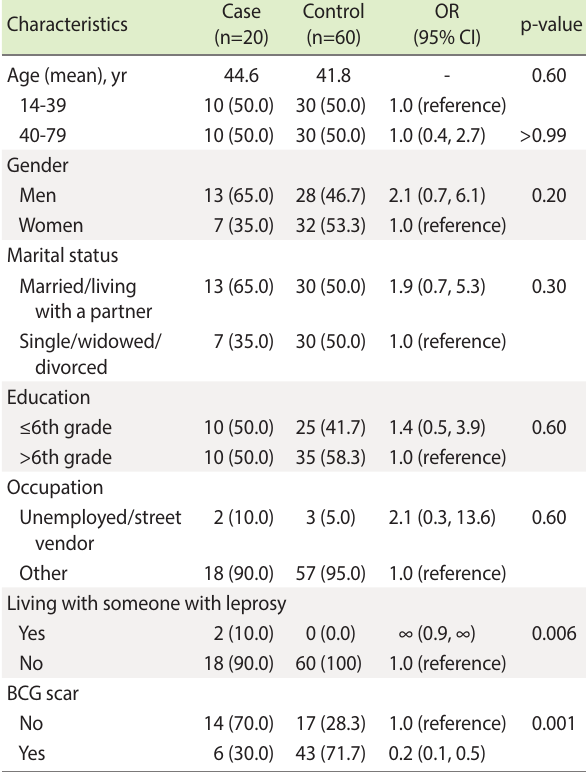
Table 1. Comparison of leprosy cases and controls by demograph- ics, contact with other leprosy cases, and BCG scarring, Ciudad del Este, Paraguay,